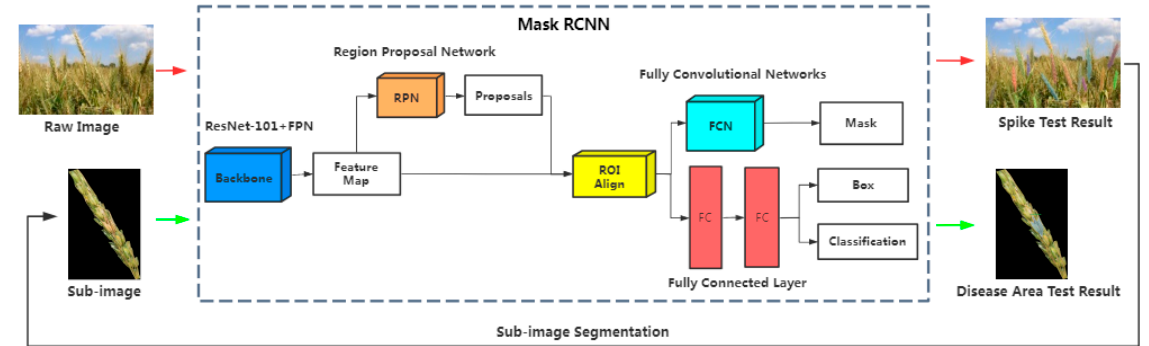
Figure 2. The architecture of the mask region convolutional neural network (Mask-RCNN) approach for wheat Fusarium head blight (FHB) disease assessment.